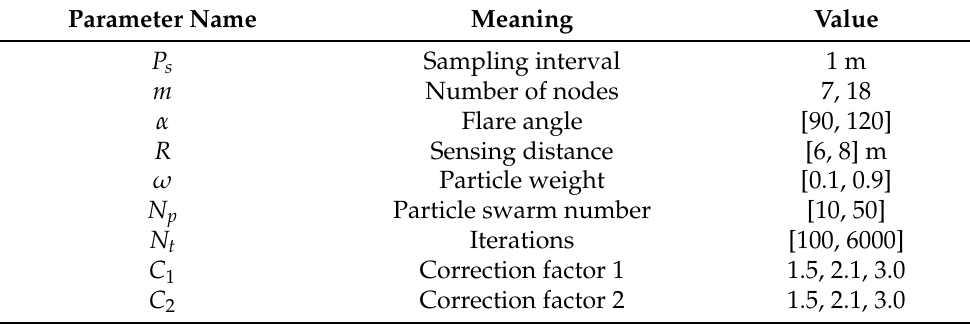
Table 1. Specifications of the parameters of Virtual Angle Boundary-aware Particle Swarm Optimiza- tion (VAB-PSO) algorithm.